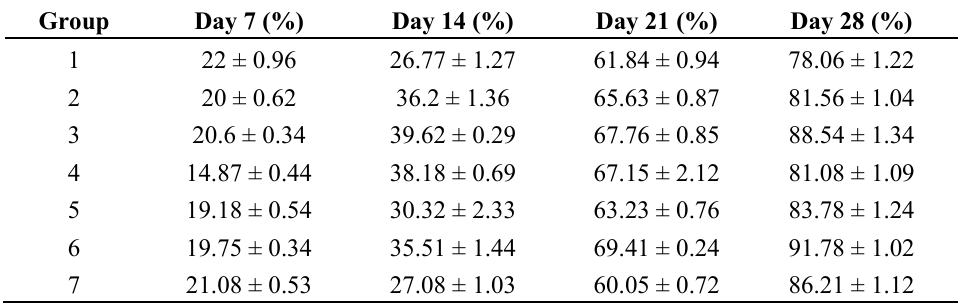
Table 3. Effect of carbazole alkaloids [mahanine (G2), mahanimbicine (G3),